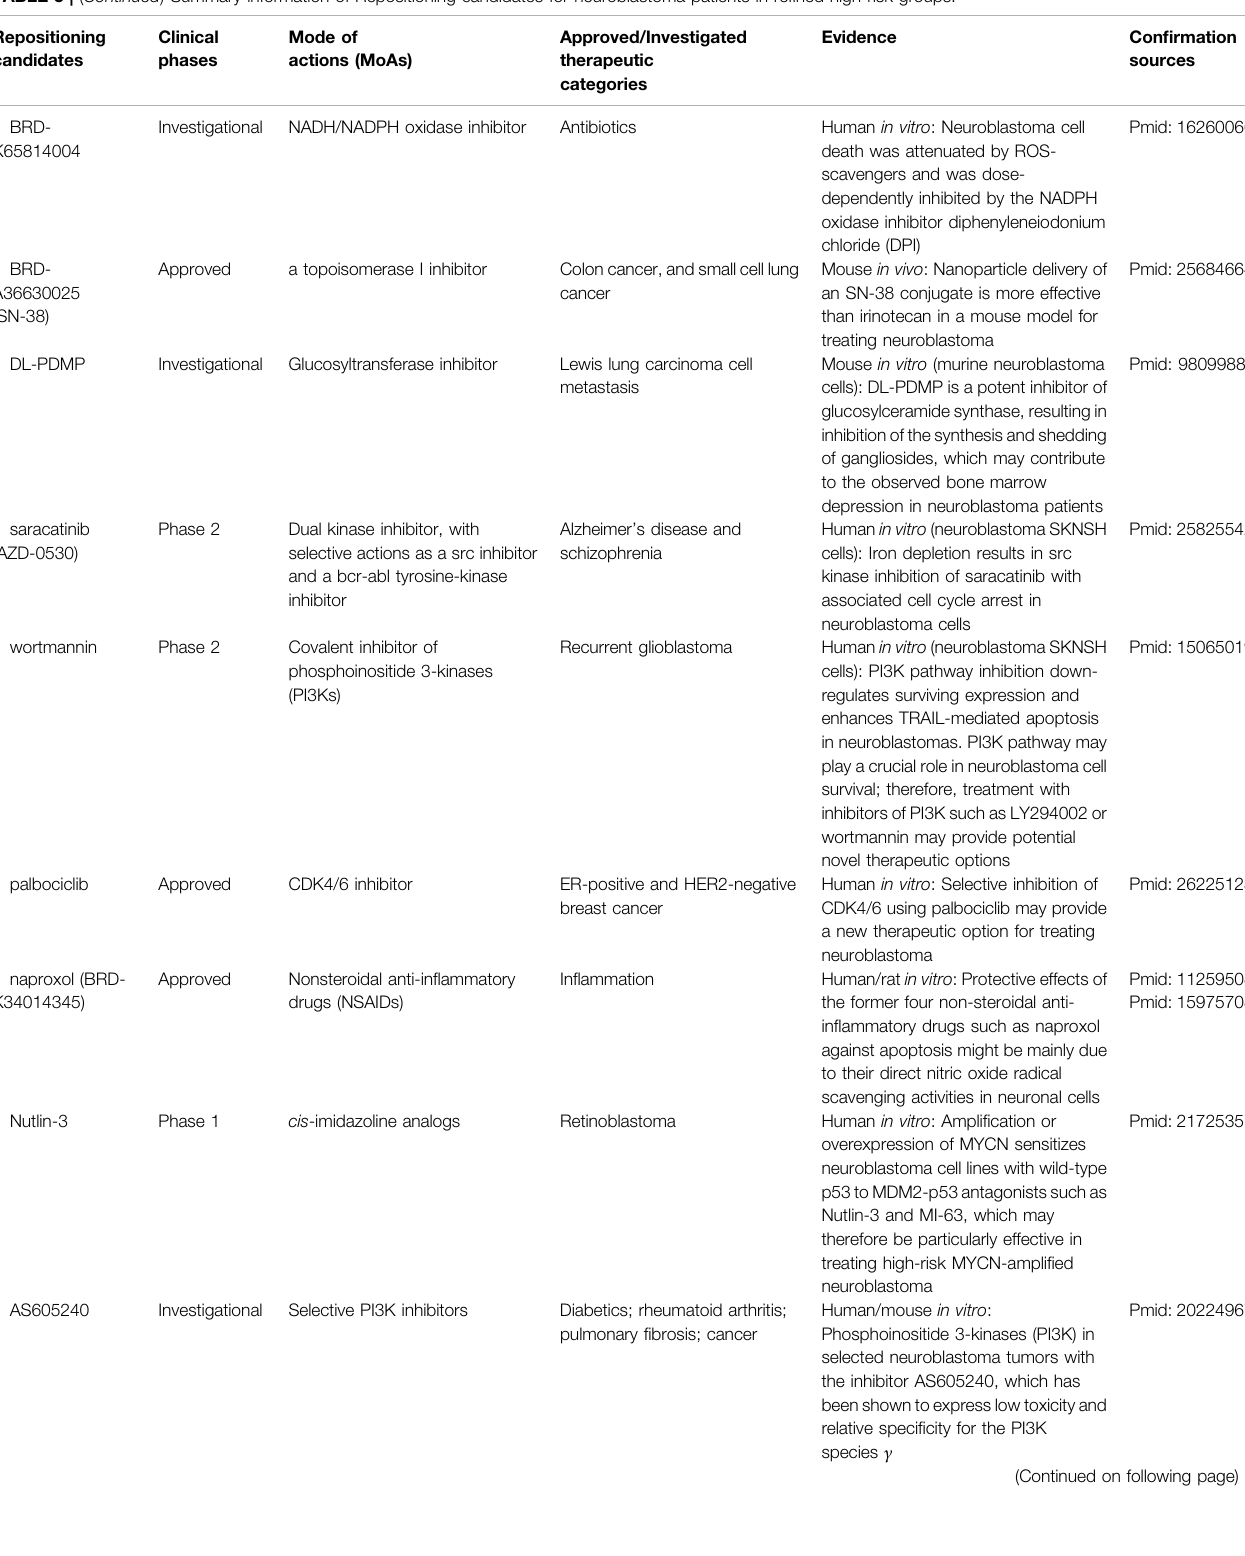
TABLE 3 | ( Continued ) Summary information of Repositioning candidates for neuroblastoma patients in re fi ned high-risk